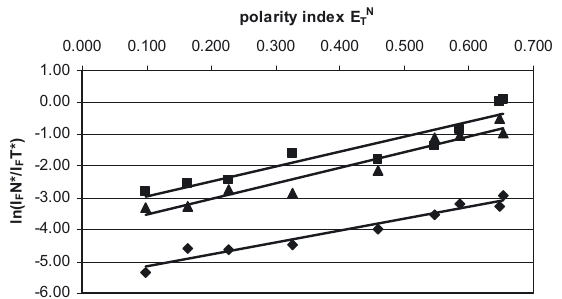
Figure 3. Solvatochromic and solvatofluorochromic behavior of 2-(benzimidazol-2-yl)-3-hydroxychromone derivatives 2a-c : positions of the absorption ( ♦ ), normal ( ■ ) and phototautomer ( ▲ ) emission maxima versus solvent polarity index E order of solvents listed in Table 1.